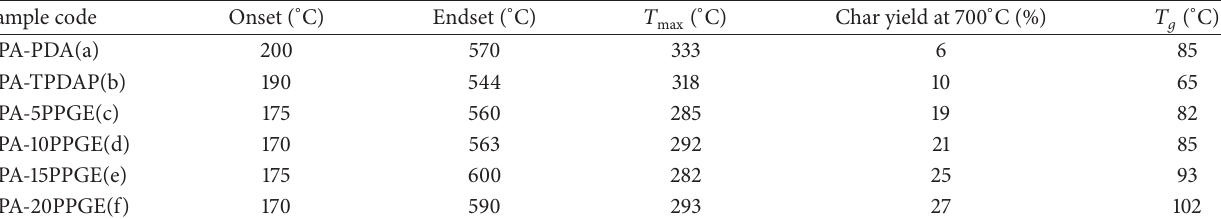
Table 5: TGA analysis of epoxy-PPGE system.